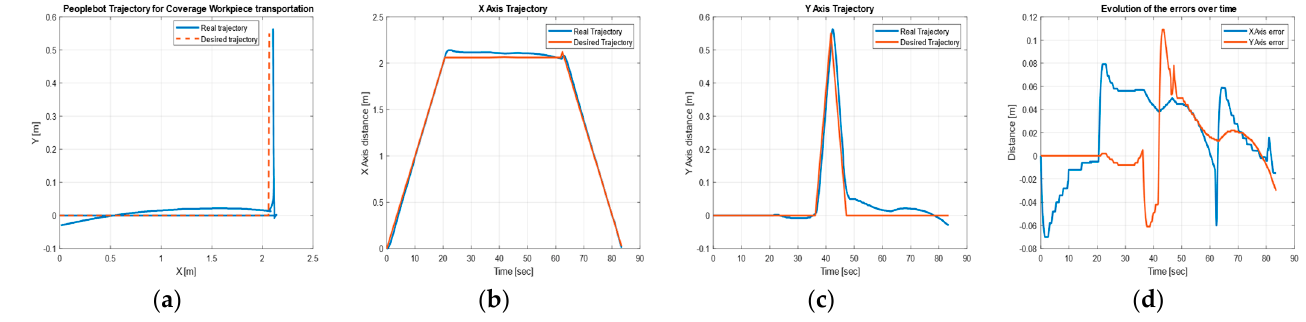
Figure 25. CAS’s DT-TTSMC for top recovery: ( a ) desired and real trajectory; ( b ) along the X axis; ( c ) along Y axis; ( d ) errors.